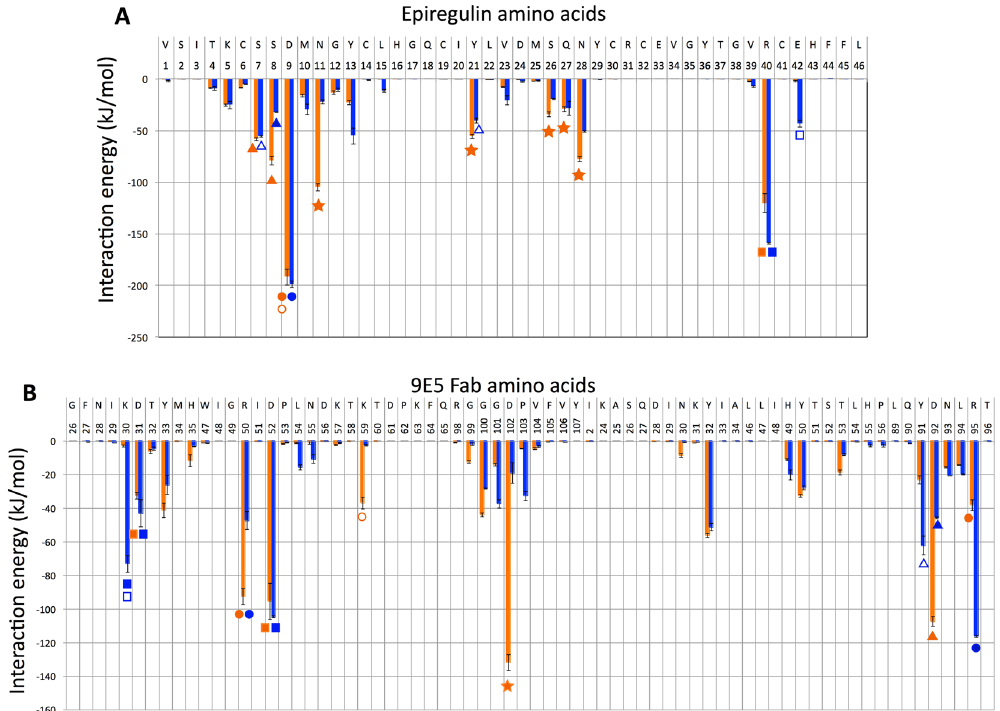
Figure 3. Comparison of a breakdown of the interaction energy between individual residues for the cis- complex and the trans-complex. The calculated interaction energies were averaged over four (trans-complex) or ten (cis-complex) independent trajectories from 2.9 to 3 μ s. Orange and blue bars represent the cis-complex and the trans-complex, respectively. Error bars indicate the standard error. The same markers shown at the bottom of the bars indicate residue pairs between 9E5 and EPR interacting with each other. ( A ) Interaction energy between individual EPR residues and the whole 9E5 antibody molecule. ( B ) Interaction energy between individual 9E5 antibody residues and the whole EPR molecule. Residues are represented using the one-letter code for amino